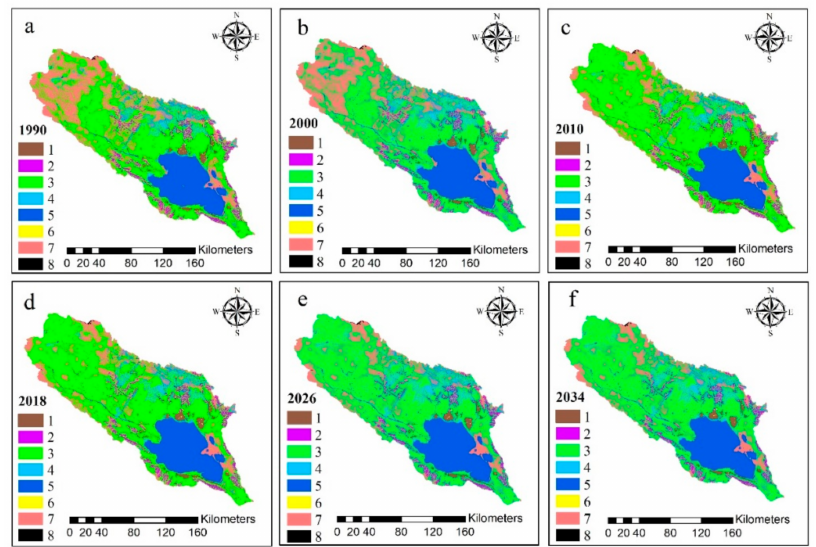
Figure 6. Spatial distribution of landscape types in the QLB. ( a ) 1990, ( b ) 2000, ( c ) 2010, ( d ) 2010, ( e ) simulated 2026, and ( f ) simulated 2034. 1—cropland, 2—woodland, 3—grassland,